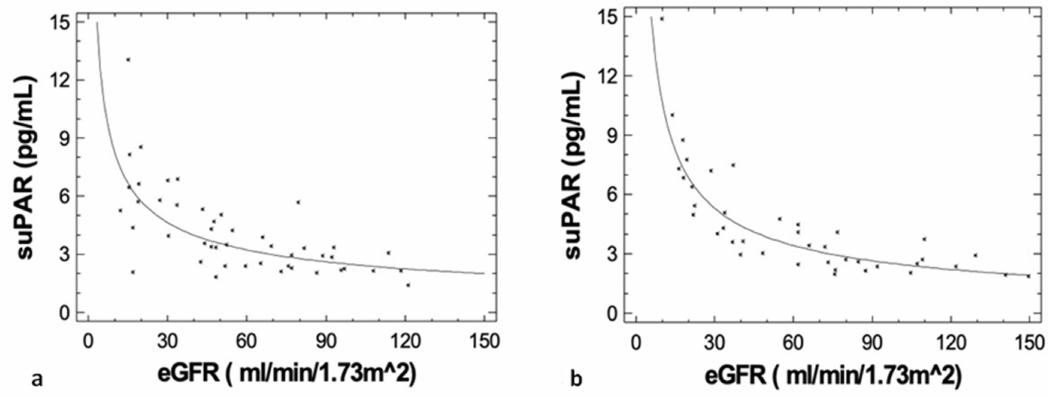
Figure 3. SuPAR levels were negatively associated with estimated glomerular filtration rate (eGFR) values both ( a ) at diagnosis (r = − 0.700, p < 0.001) and ( b ) at best response (r = − 0.890, p <